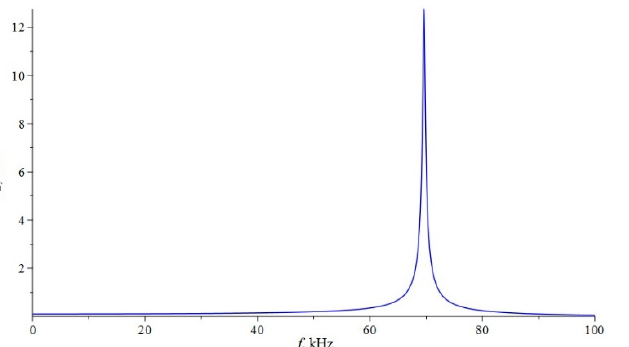
Figure 12. Asymmetric two-layer magnetoelectric composite for calculation of longitudinal-shear mode. All designations are the same as in Figure 9.